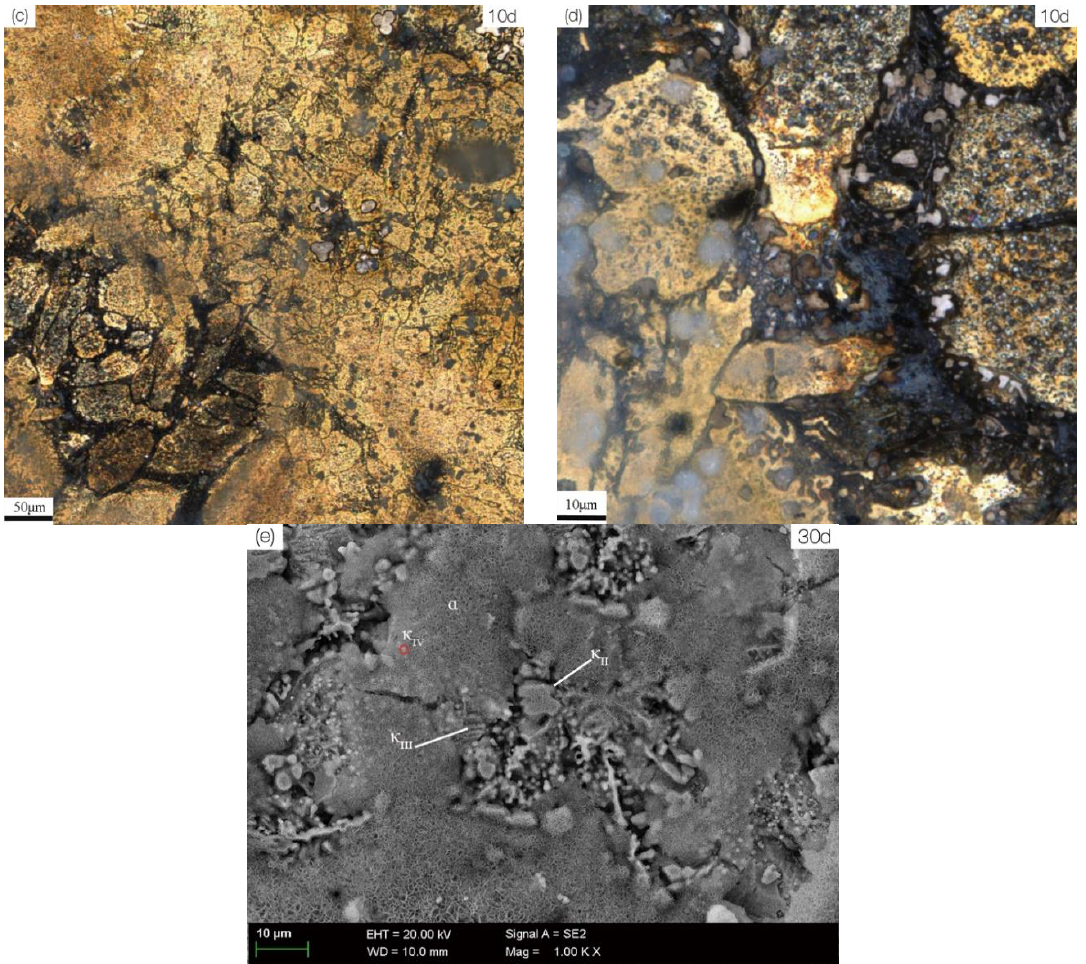
Figure 6. The corrosion morphology of for S-Cast immersed in artificial seawater at different times: ( a ) 3 d; ( b ) local magnification at 3 d; ( c ) 10 d; ( d ) local magnification at 10 d; ( e ) 30 d.